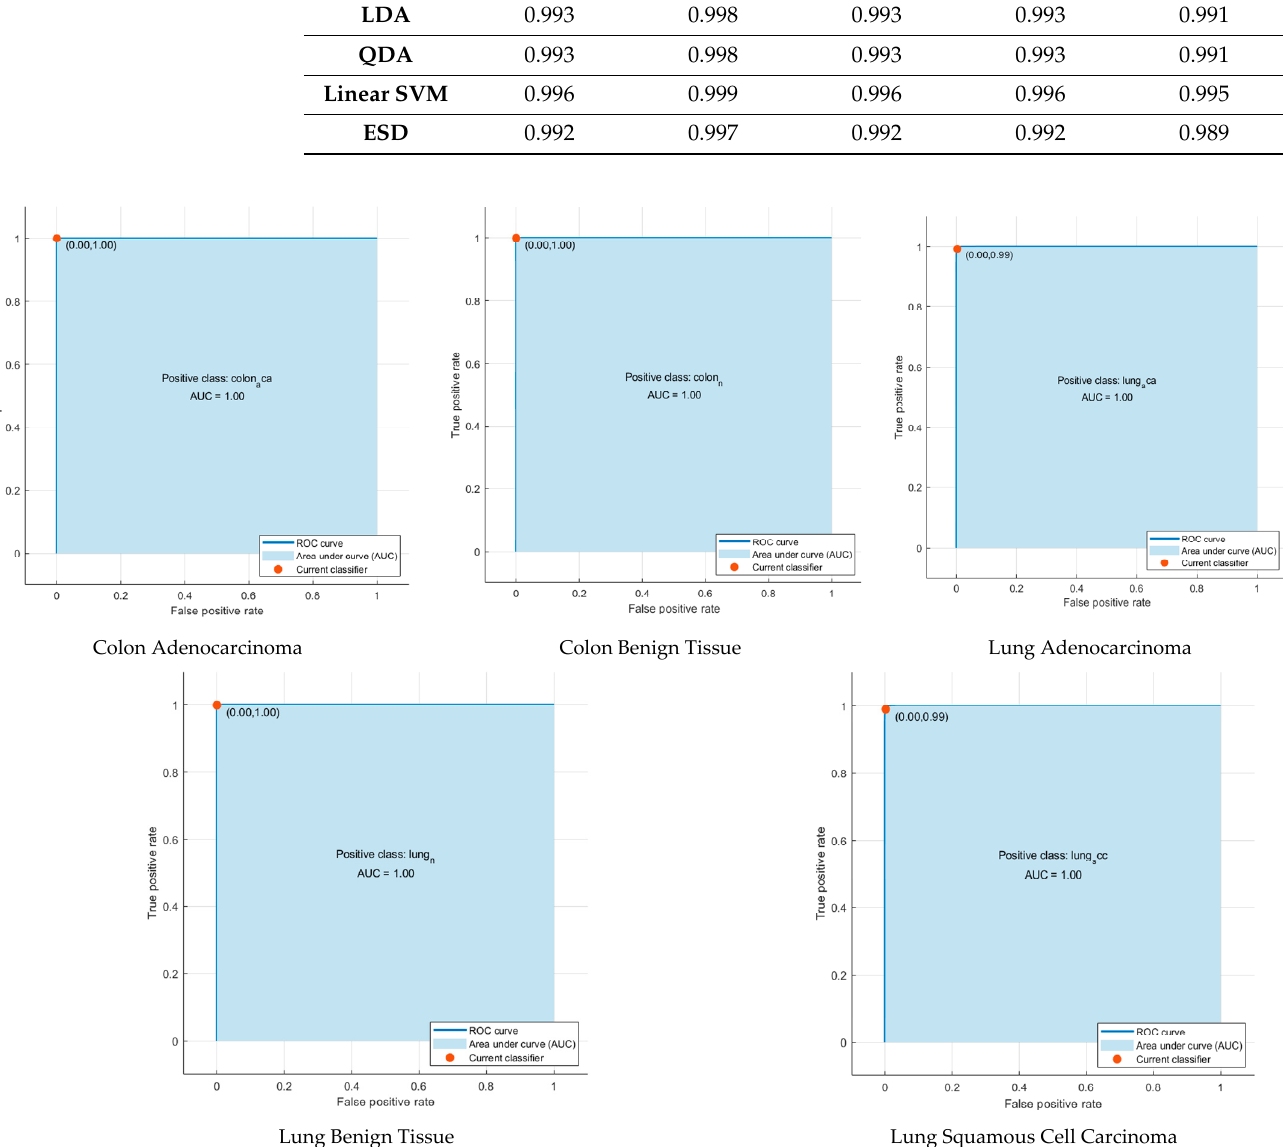
Figure 10. ROC curves of each class as a result of the CNN-FHWT-SVM structure. Table 4. Performance measures attained using the combined FHWT coefficients of the three CNNs via the DWT